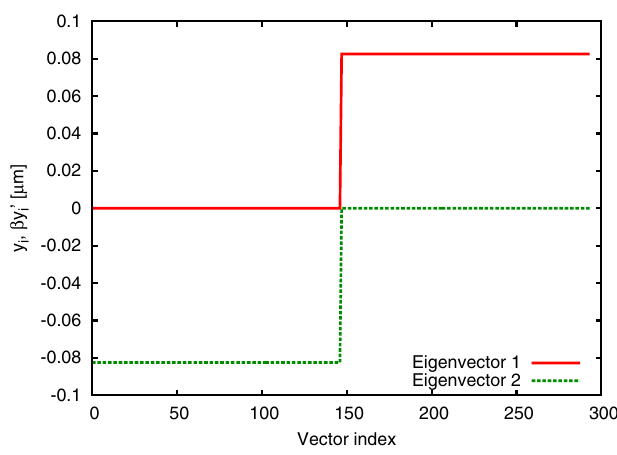
FIG. 8. The two eigenvectors of H with zero eigenvalues correspond to a uniform change of positions and angles, respec-